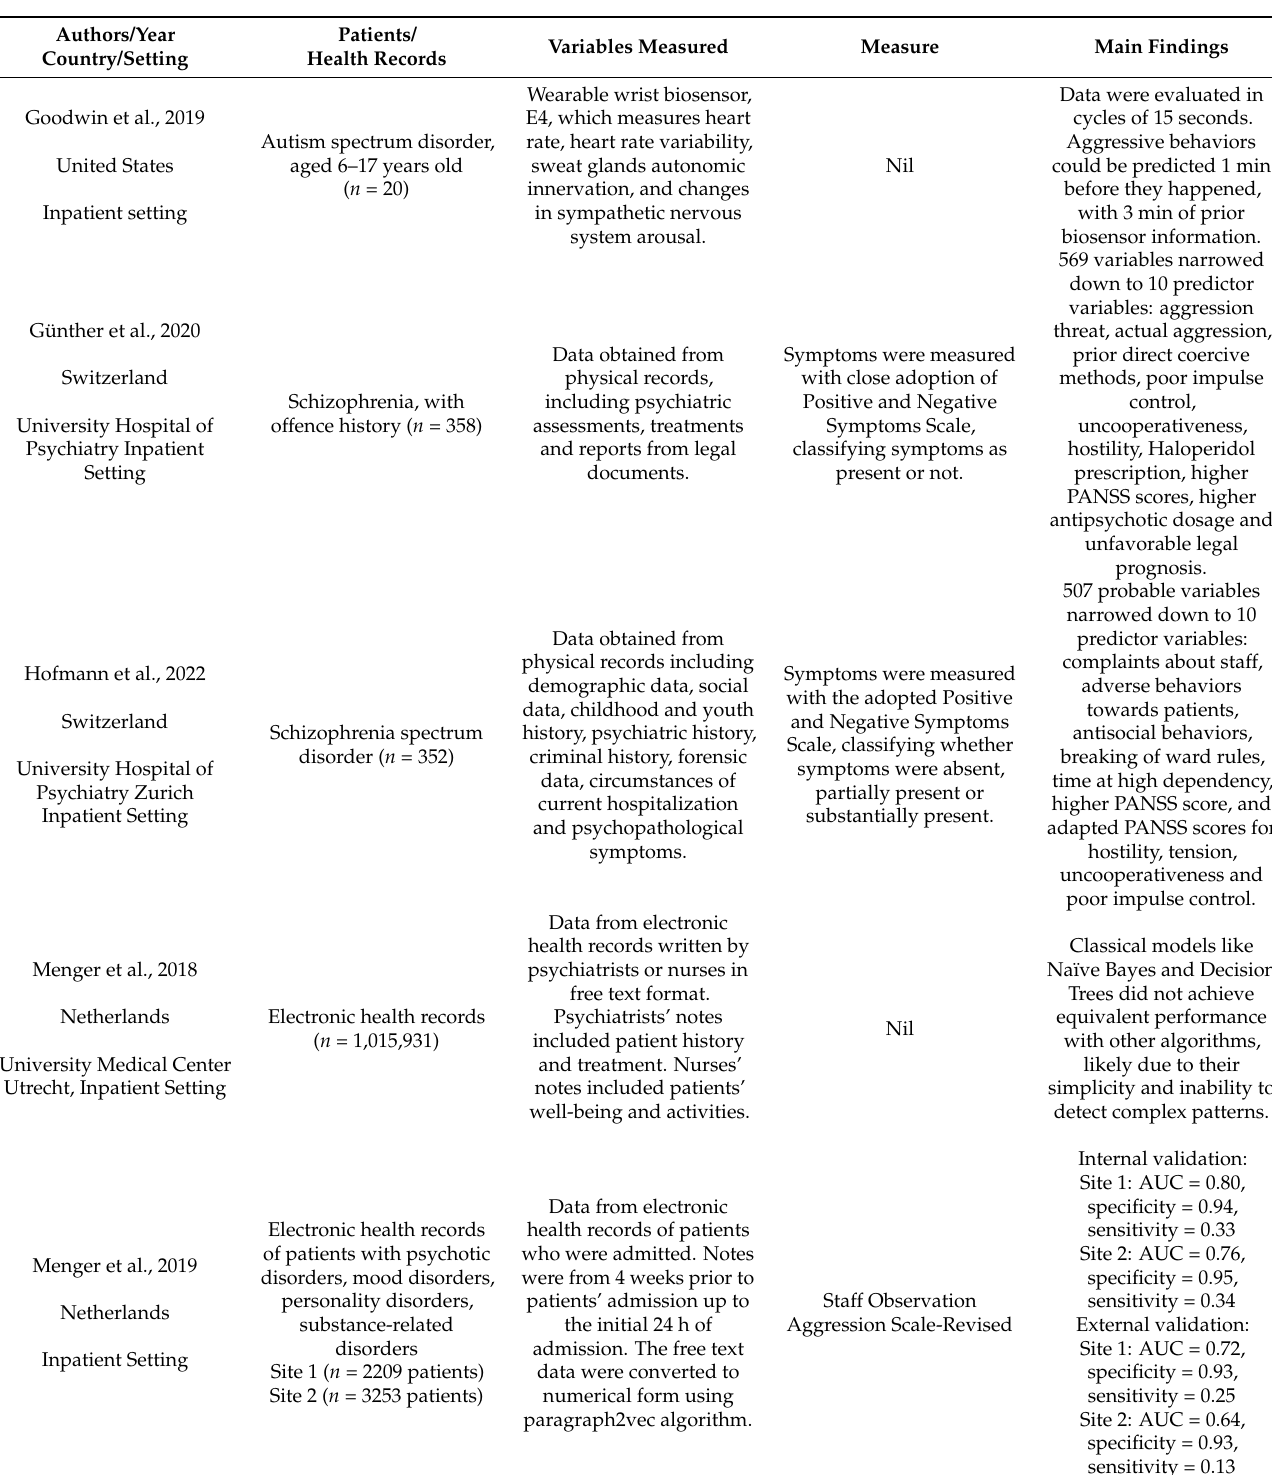
Table 1. Details of included